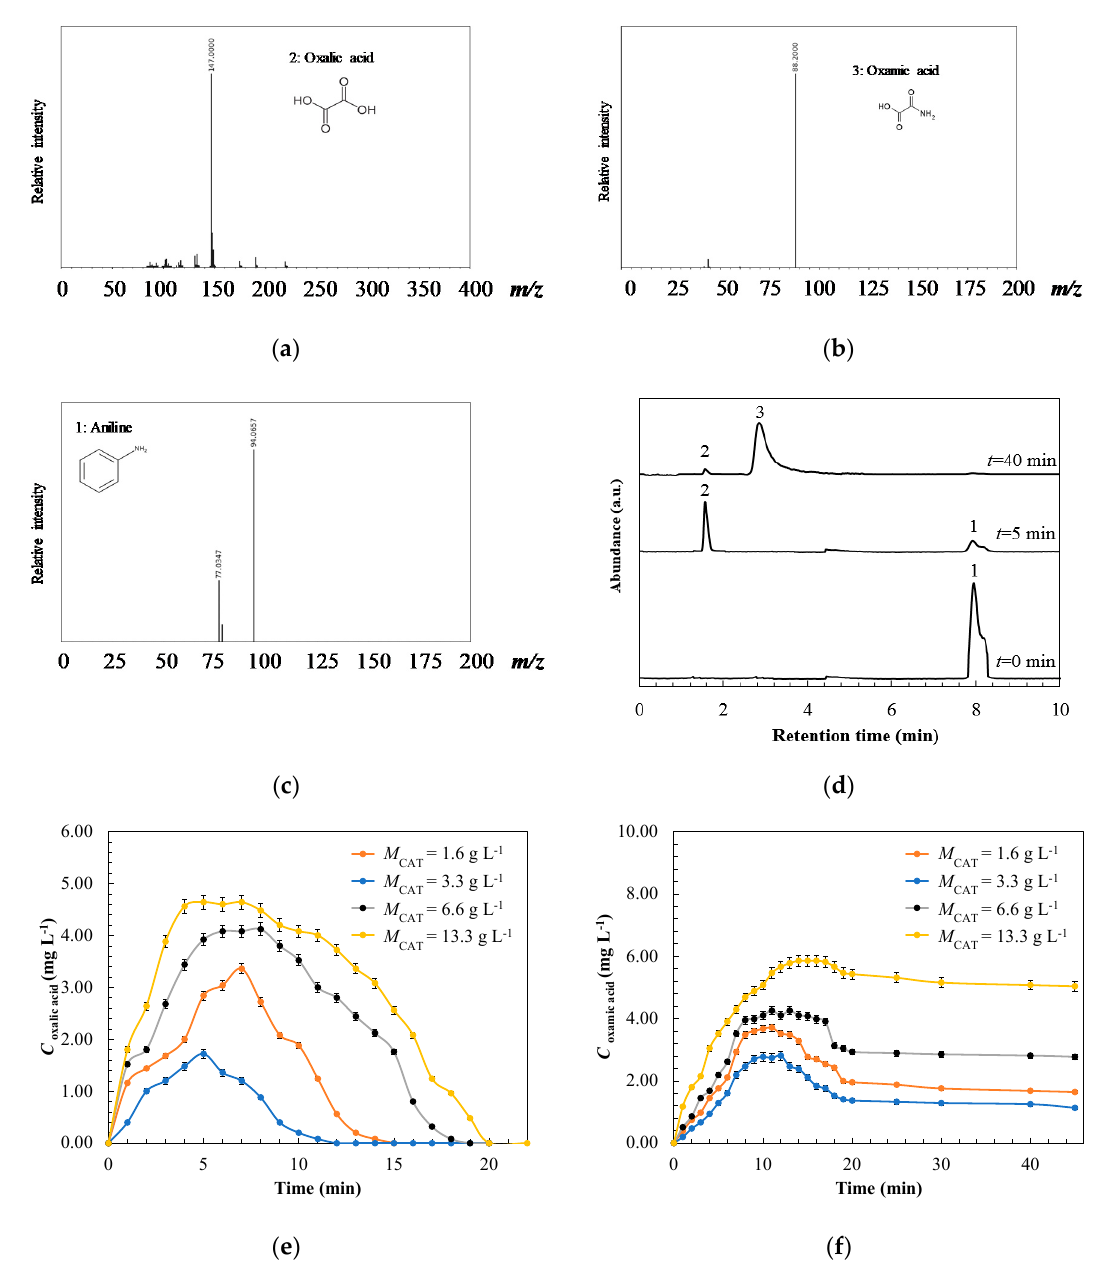
Figure 6. Analysis of some by-products formed during the TiO 2 /GAC ozonation of aniline: ( a – c ) mass spectrometry (MS) of the aniline at different ozonation times, ( d ) liquid chromatography (LC) of the aniline and representative ozonation by-products, and ( e , f ) effect of catalyst dosage on the evolution of oxalic and oxamic acid during ozonation. Experimental conditions: Q G = 4 L min − 1 ; C O 3,in = 5.4 mg L − 1 ; pH = 7.0; T = 18.0 °C; P = 1 atm; V reac = 1.5 L; ( Agitation ) = 60 rpm.